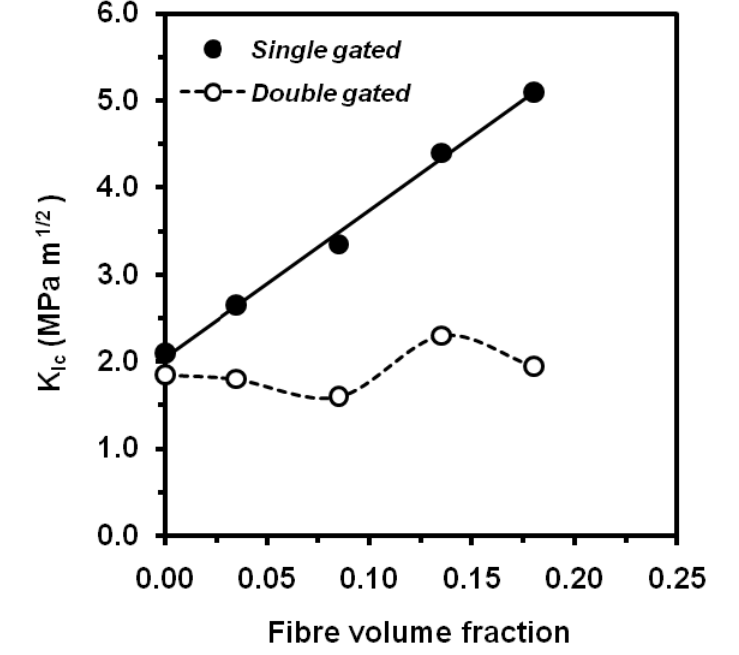
Figure 34. Influence of short glass fibre content on K composites.(adapted from